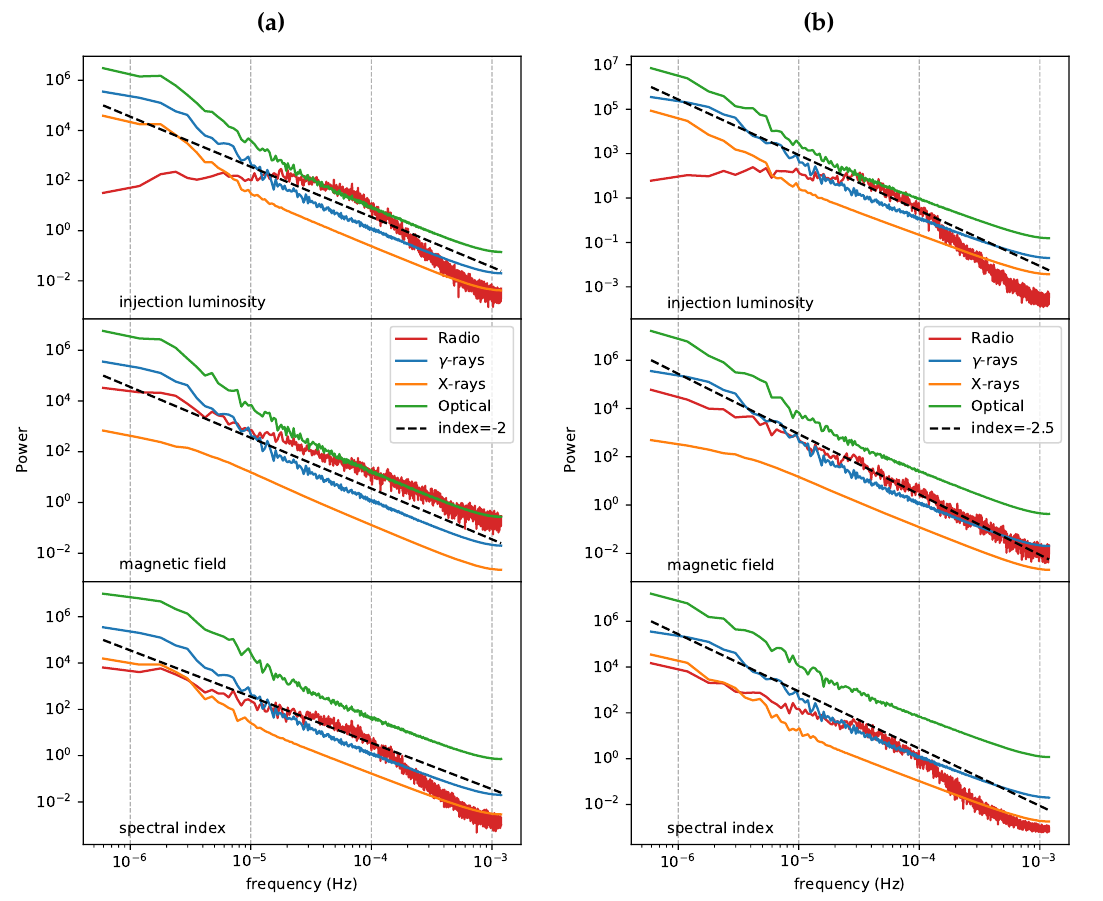
Figure 5. Average PSDs of multiple realisations of the variability model. Optical PSDs offset by 10 1 and X-ray PSDs by 10 − 1 for clarity. ( a ) Seed power law index α = 2.0. ( b ) Seed index α =